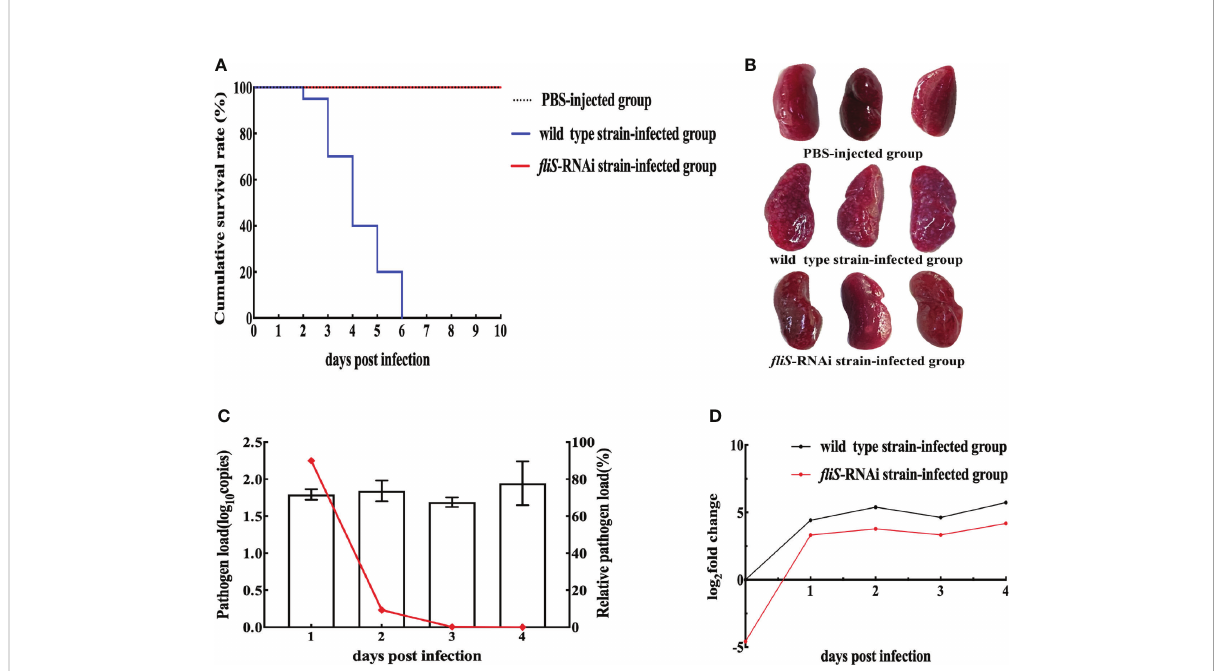
FIGURE 3 Pathogenicity of two P. plecoglossicida strains against E coioides . (A) Survival rate. (B) Symptoms in E coioides spleens at 4 dpi. (C) Pathogen load of fl iS -RNAi strain in E coioides spleens during infection. Column represents pathogen load in spleen, represented by copy number of housekeeping gene gyrb . Line graph represents relative pathogen load value (i.e., copy number of gyrB gene of fl iS -RNAi strain/copy number of gyrB gene of wild type strain). (D) mRNA expression level of fl iS gene of P. plecoglossicida in E coioides spleens during